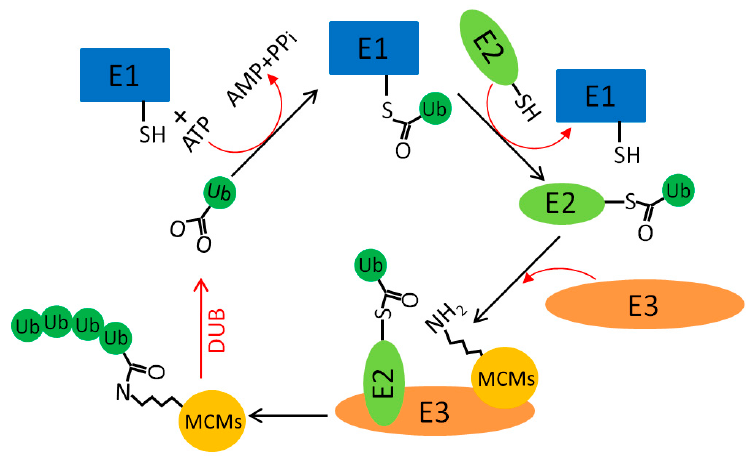
Figure 2. MCM ubiquitination.